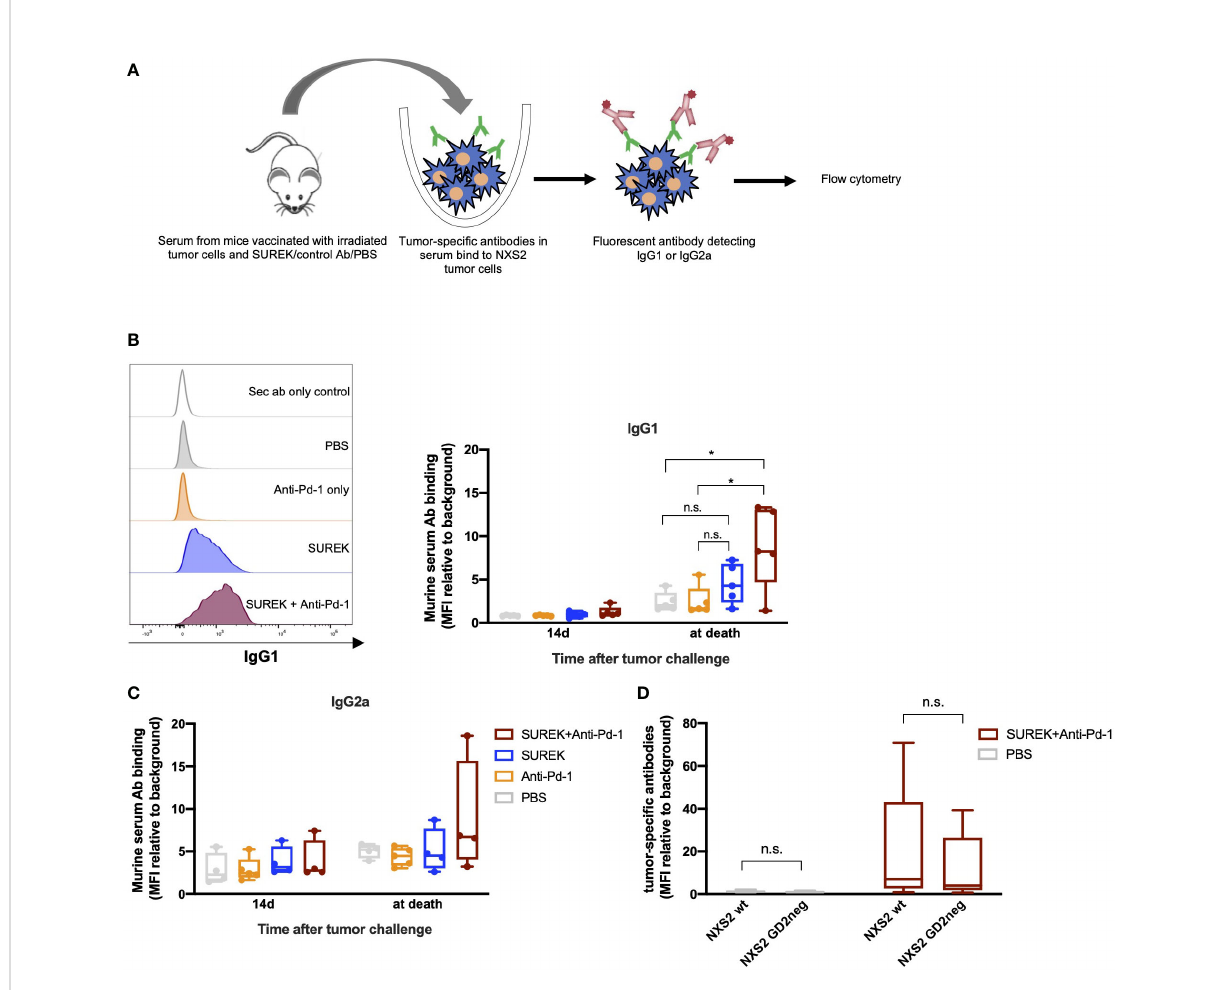
FIGURE 5 Combination therapy of SUREK with anti-Pd-1 antibody induces tumor-speci fi c antibodies and T cell memory in mice. (A) Schematic representation of experiment and analysis. (B) Exemplary histograms (left panel) and quanti fi cation (mean fl uorescence intensity (MFI)) relative to background, right panel) showing secondary IgG1 antibodies binding on NXS2 cells incubated with serum of mice that received the